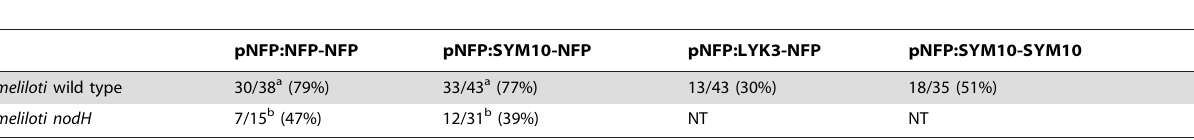
Table 1. Number of plants showing pMtENOD11:GUS induction in nfp pMtENOD11:GUS roots transformed with pNFP:NFP-NFP, pNFP:SYM10-NFP or pNFP:LYK3-NFP, 7 dpi with S. meliloti wild type or S. meliloti nodH .